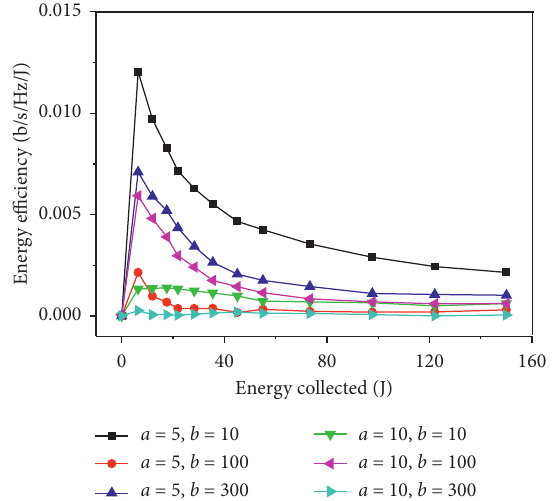
Figure 7: The IoT energy efficiency results achieved by the pro- posed scheme when ρ �